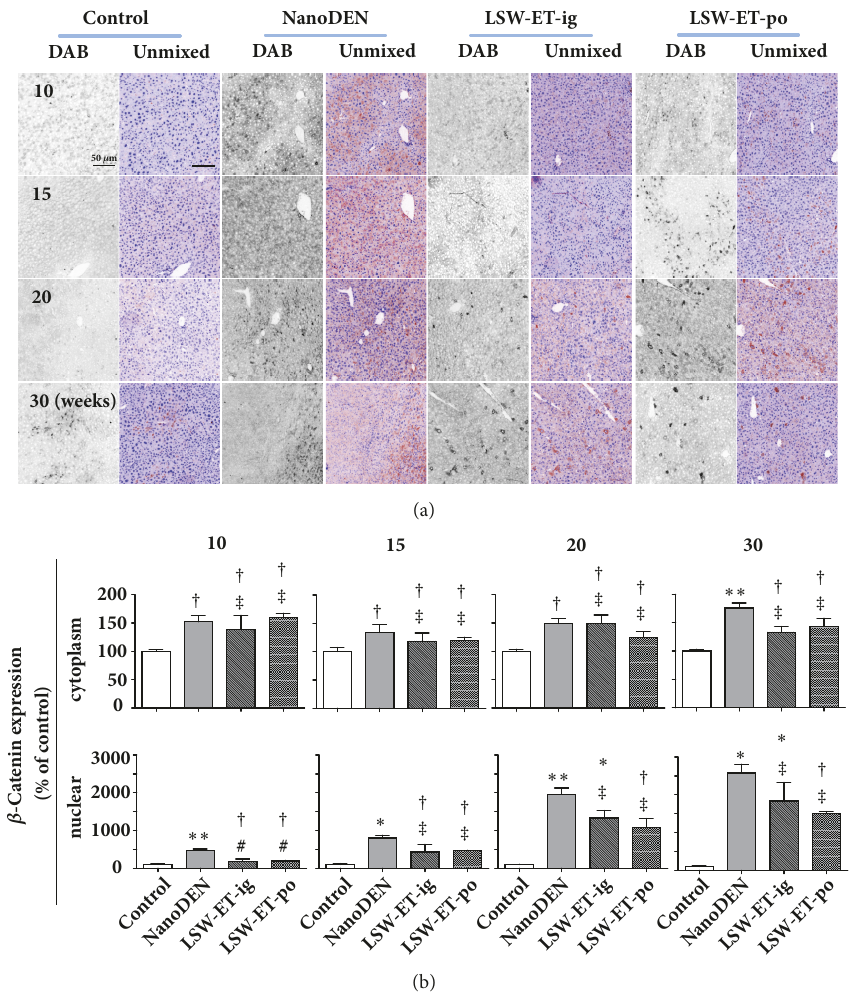
Figure 5: Oral application of L S W-ET decreased the nano D EN-induced 𝛽 -catenin expression in mice. (a) The expression of 훽 -catenin by immunohistochemistry. Scale bar, 50 휇 m. (b) Quantitative expression of the cytoplasmic and nuclear expression of 훽 -catenin determined by